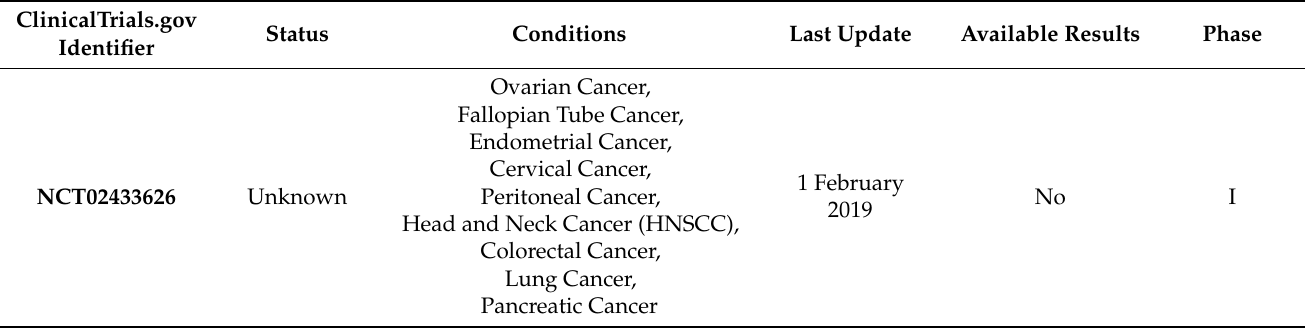
Table 3. Clinical trial for the use of COTI-2 in oncology